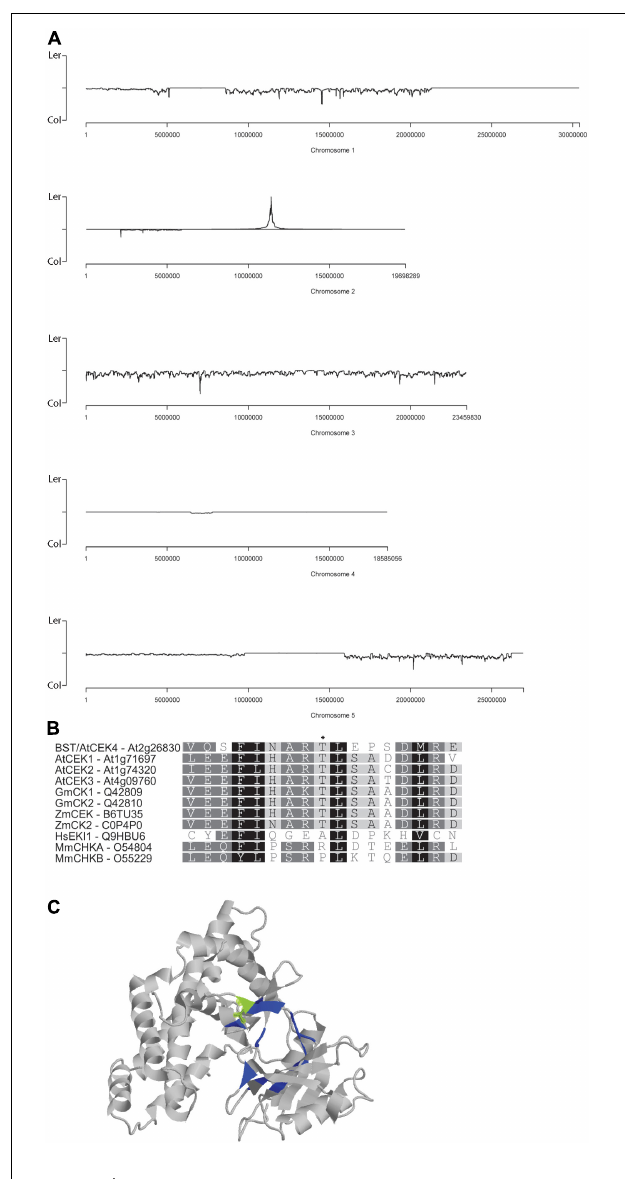
FIGURE 2 | Cloning and characterization of bst . bst was simultaneously mapped and cloned using a NGS approach. bst was generated in a Ler background and its position on chromosome 2 can be seen as peak of enrichment in Ler SNPs (A) . A protein alignment of CEKs from Arabidopsis (At), soybean (Gm), maize (Zm), humans (Hs), and mice (Mm) centered on T144 (indicated with a *) which is the site of the T144I mutation in bst (B) . CEK4 structure with the ATP binding pocket visible. Residues that participate in ATP binding are shaded blue and T141 is shaded green. Image generated using the molecule viewer at bar.utoronto.ca/eplant (Waese et al., 2017) (C)